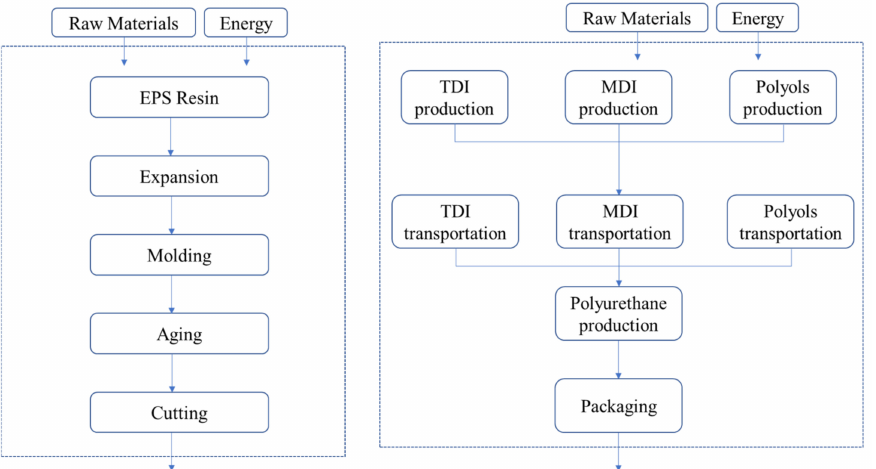
Figure 5. Cradle-to-gate flow diagram of EPS and polyurethane